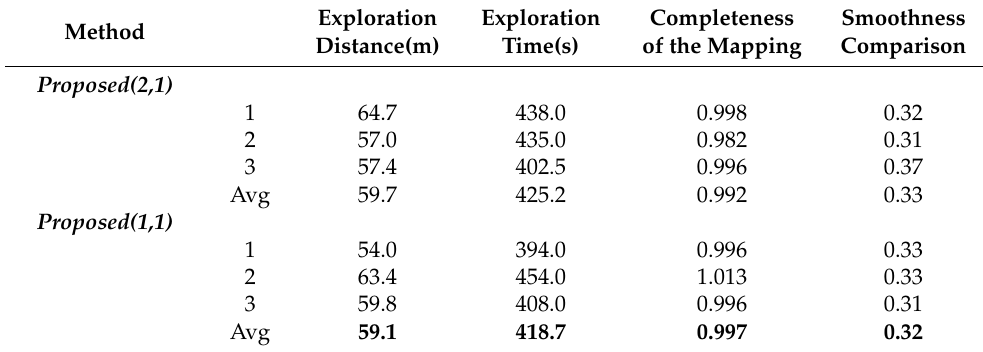
Table 5. Experimental data of the proposed method in real environments.